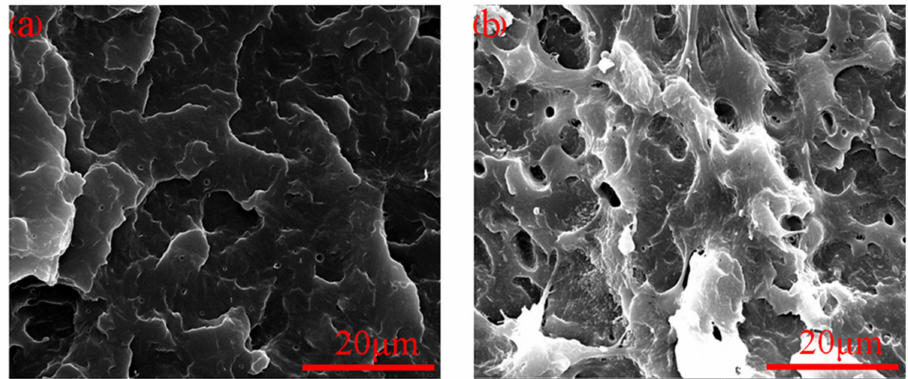
Figure 7. SEM of impact section of ( a ) 1P-A-M and ( b )